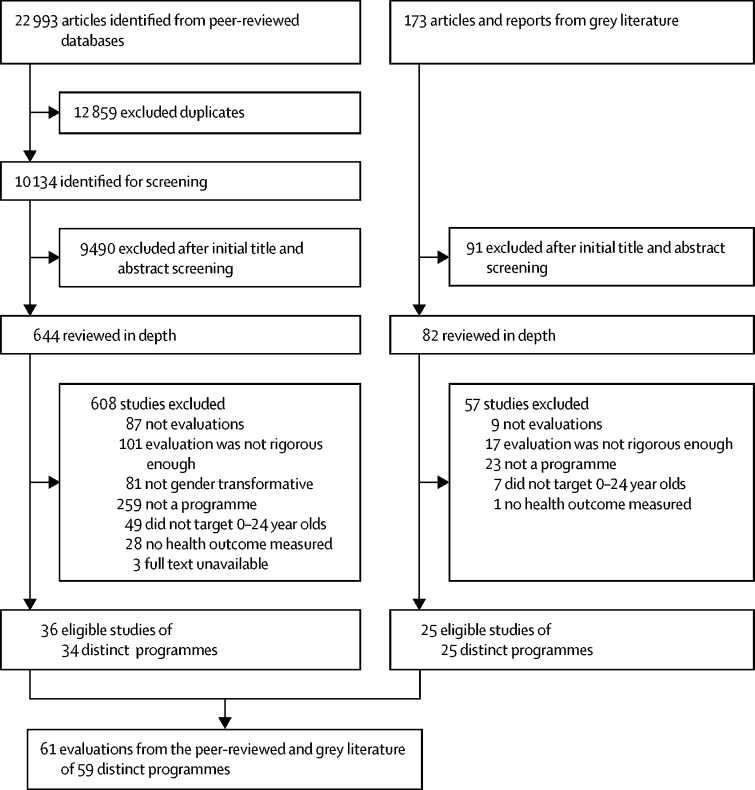
Study selection